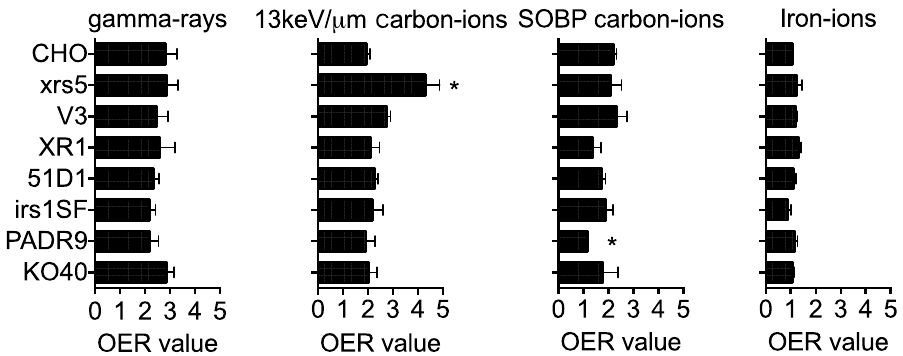
Figure 4. OER values calculated from survival curves in different qualities of radiation. RBE values are the mean ± standard error of the means. * Indicates statistically significant differences from wild type data ( p < 0.05).